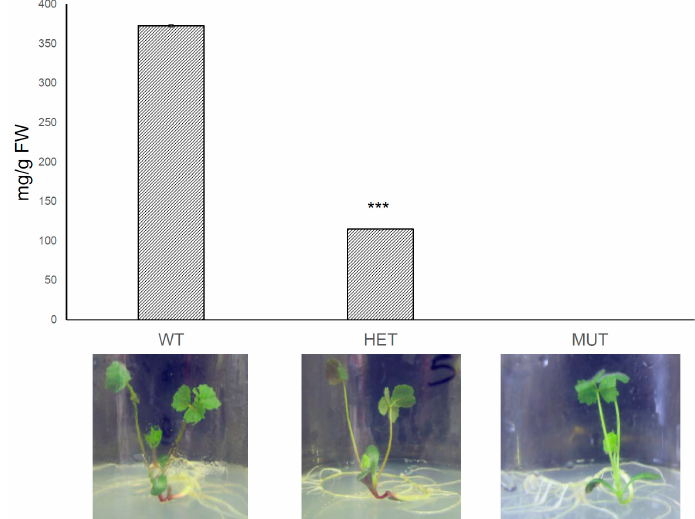
Figure 3. Anthocyanin content measured in leaves of plants cultivated in vitro on high sucrose (6%) containing medium. WT is wild-type R108. HET and MUT stands for heterozygous and homozygous referred to Tnt1 insertion in MtrGSTF7 . Anthocyanins could not be detected in MUT. Data indicate mean values ±SD of four replicates (*** p < 0.001).